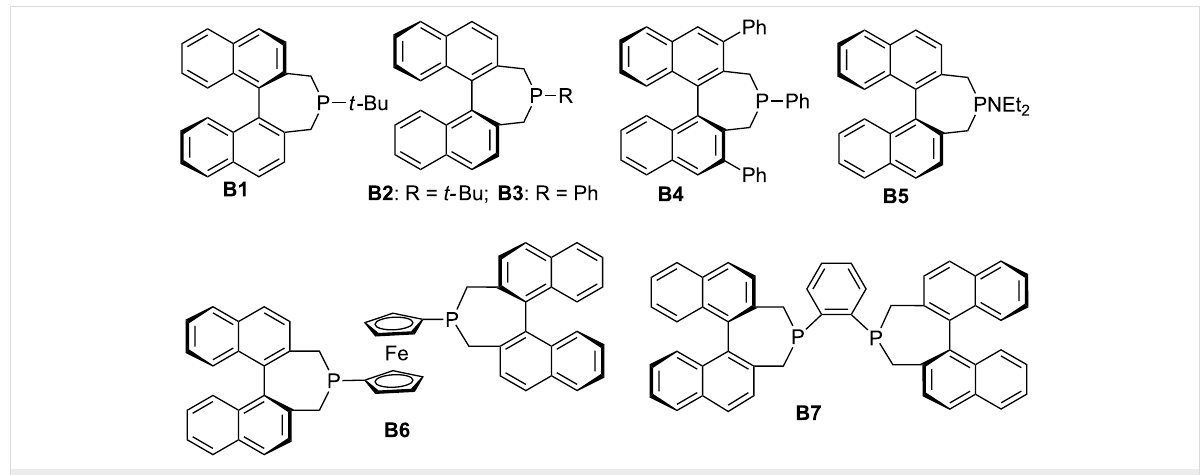
Figure 2: Cyclic chiral phosphines based on binaphthyl skeletons.